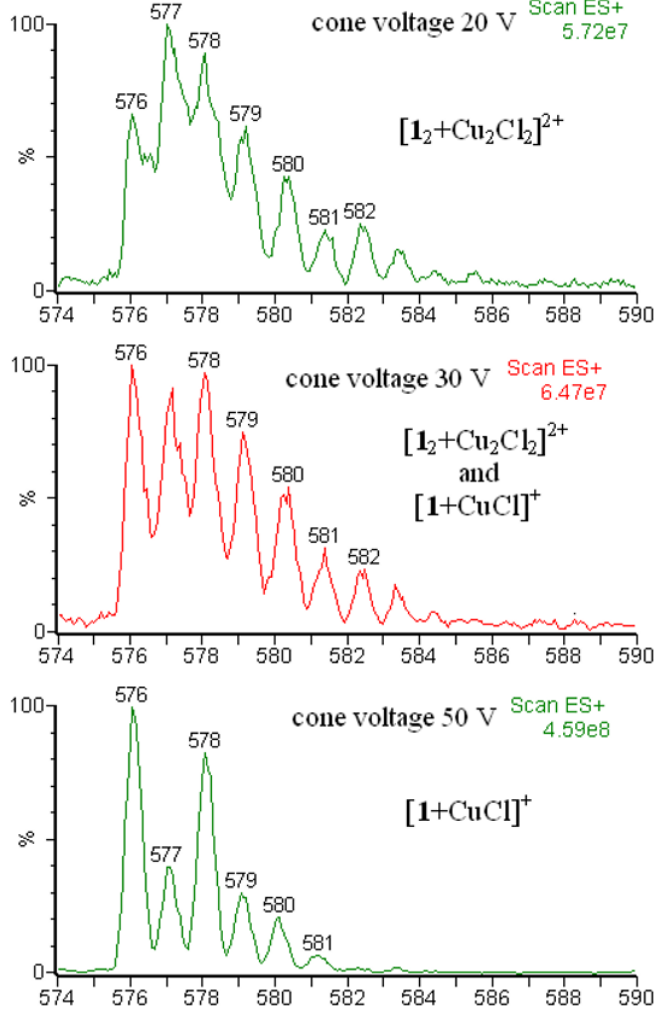
Figure 2. Isotope patterns of ions [1